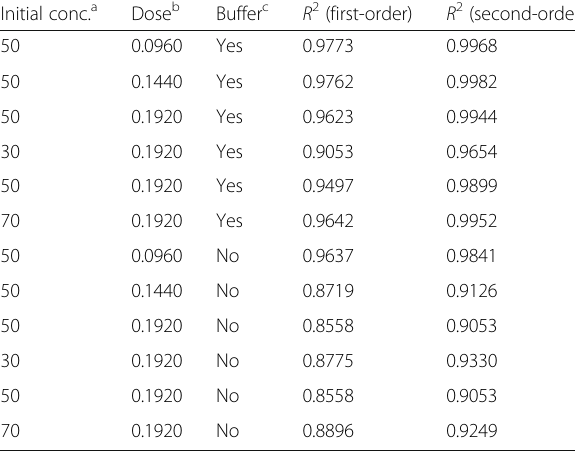
Table 1 The kinetic data under different conditions Initial conc.